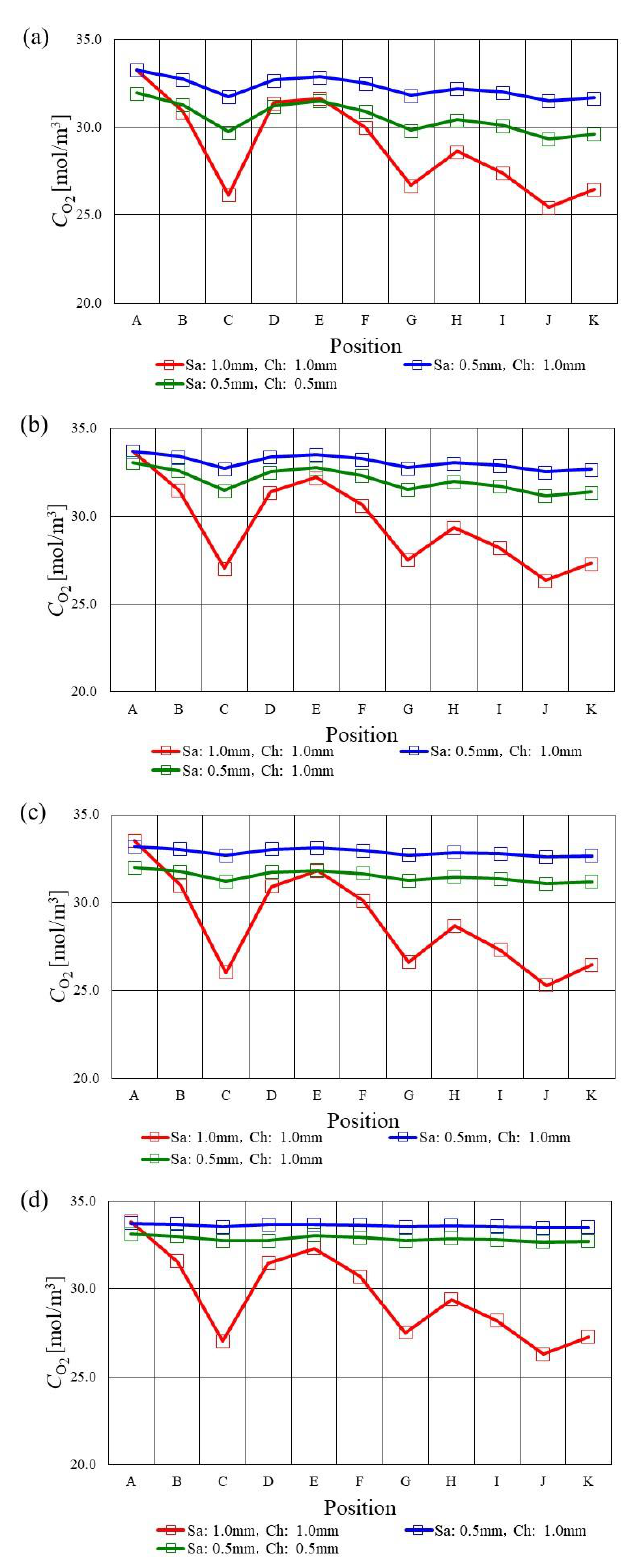
Figure 7. Molar concentration of O 2 along with the gas channel on the interface between PEM and catalyst layer at the cathode among various s.t. at T ini = 373 K. ( a ) A80%RH/C80%RH, ( b )